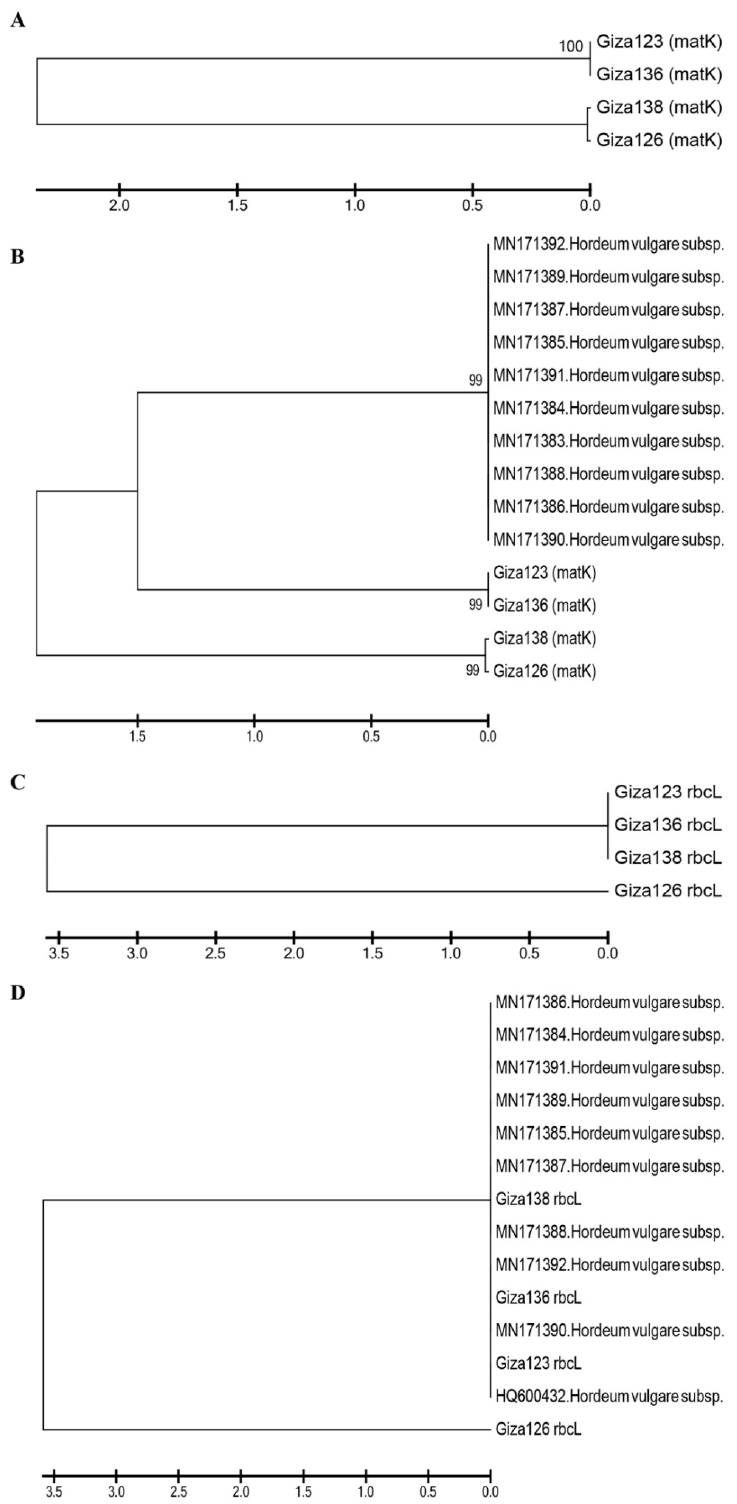
Figure 9. Phylogenetic trees based on ( A ) the mat K DNA barcoding region for four six-rowed barley cultivars (Giza 123, Giza 126, Giza 136, and Giza 138); ( B ) the mat K DNA barcoding region for four six-rowed barley cultivars, with 10 additional mat K sequences of Hordium vulgaris L. used as outgroups; ( C ) the rbc L DNA barcoding region for four six-rowed barley cultivars; and ( D ) the rbc L DNA barcoding region for four six-rowed barley cultivars, with 10 additional rbc L sequences of Hordium vulgaris L. used as outgroups, using MEGAX